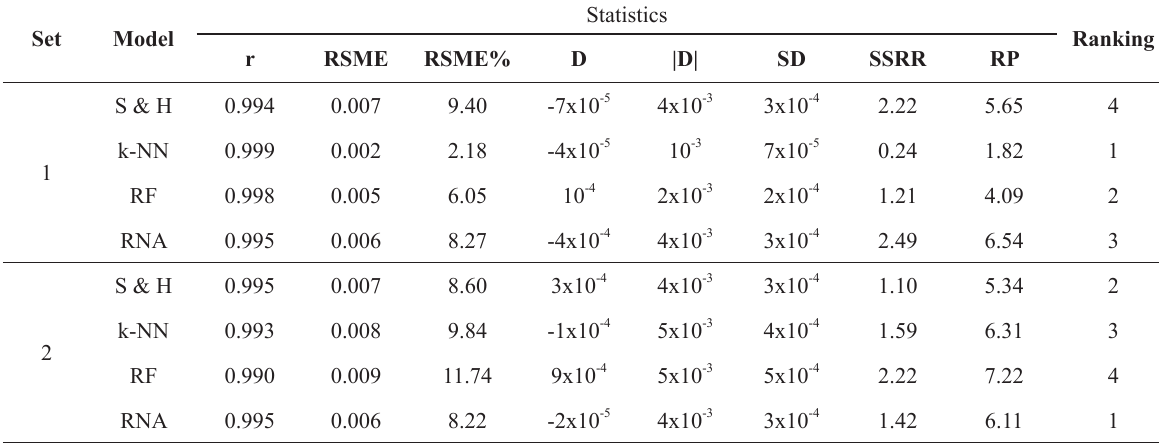
Fit statistics for estimation of stem total volume for training (1) and validation (2)